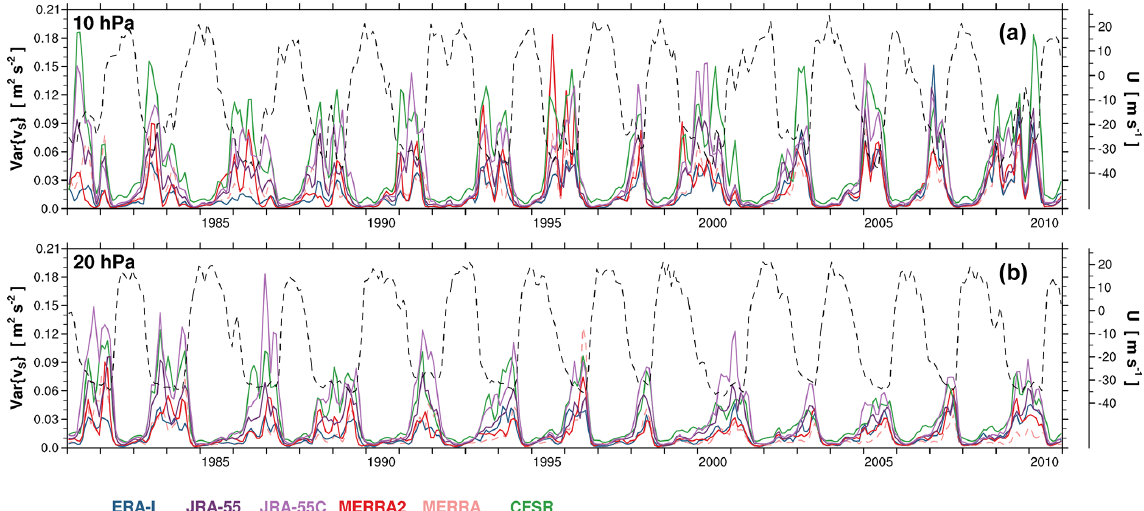
Figure 13. Monthly time series of variances of the symmetric component of meridional wind at (a) 10 and (b) 20hPa, filtered for 0 . 5 < ω < 0 . 7cycd − 1 with k = − 7 and 0 . 6 < ω < 0 . 75cycd − 1 with k = − 8 (see Fig. 2). The monthly zonal wind from radiosonde observations is also presented at each level (dashed black lines).